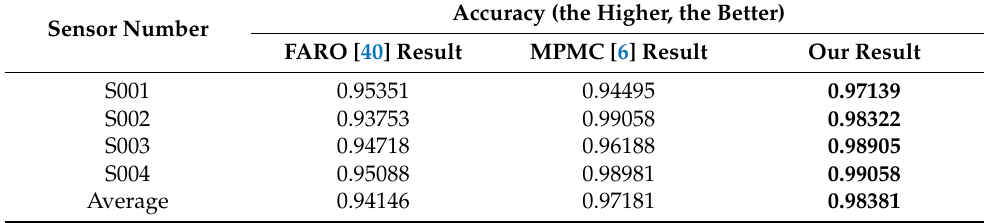
Table 6. Comparison of accuracy